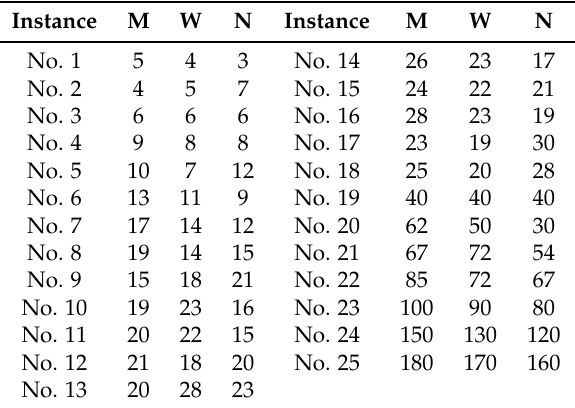
Table 3. The test instances and its